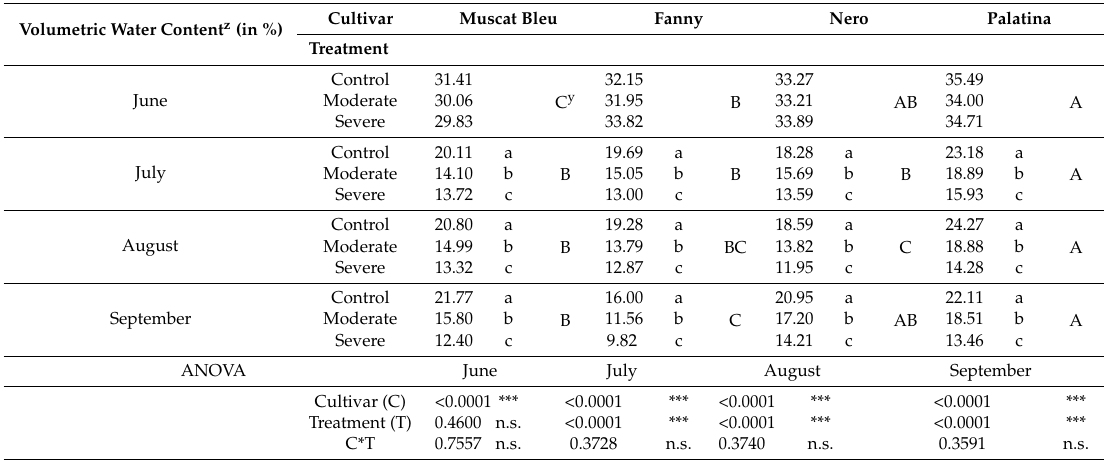
Table 5. Soil volumetric water content (in %) at soil saturation and during the experiment of four three-year-old table grape cultivars under three water deficit treatments in 2016.